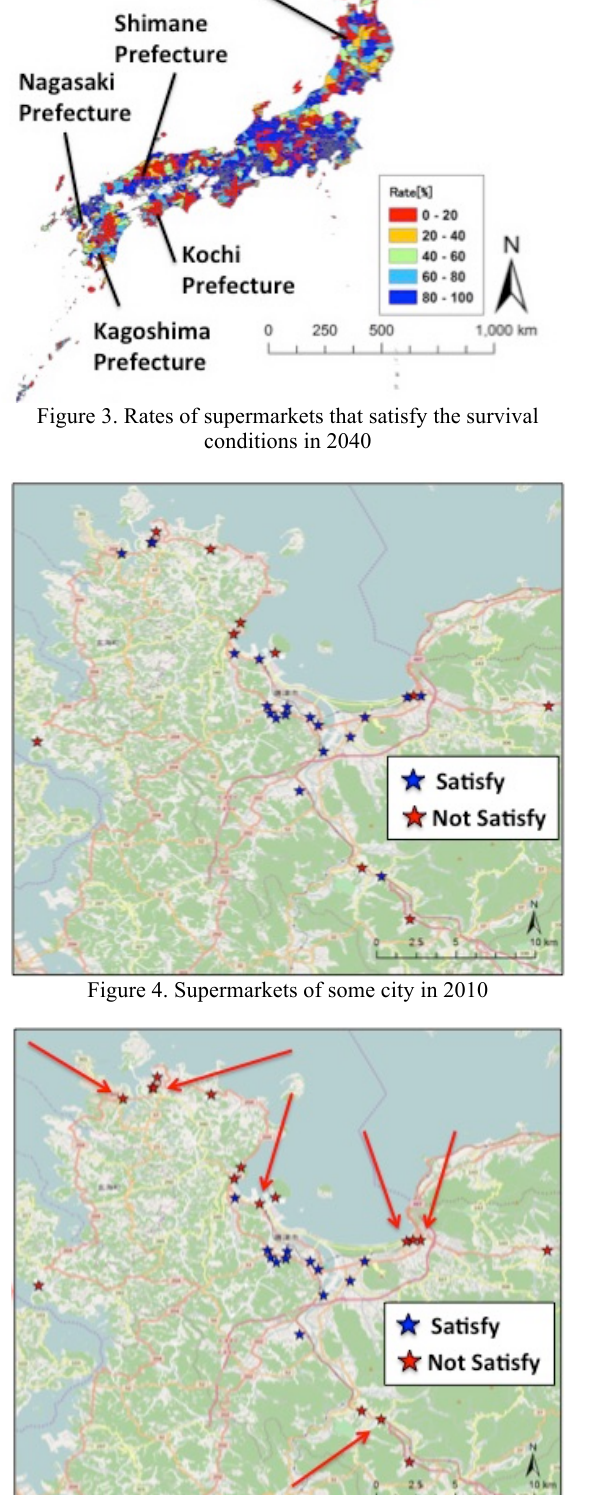
Figure 5. Supermarkets of some city in 2040